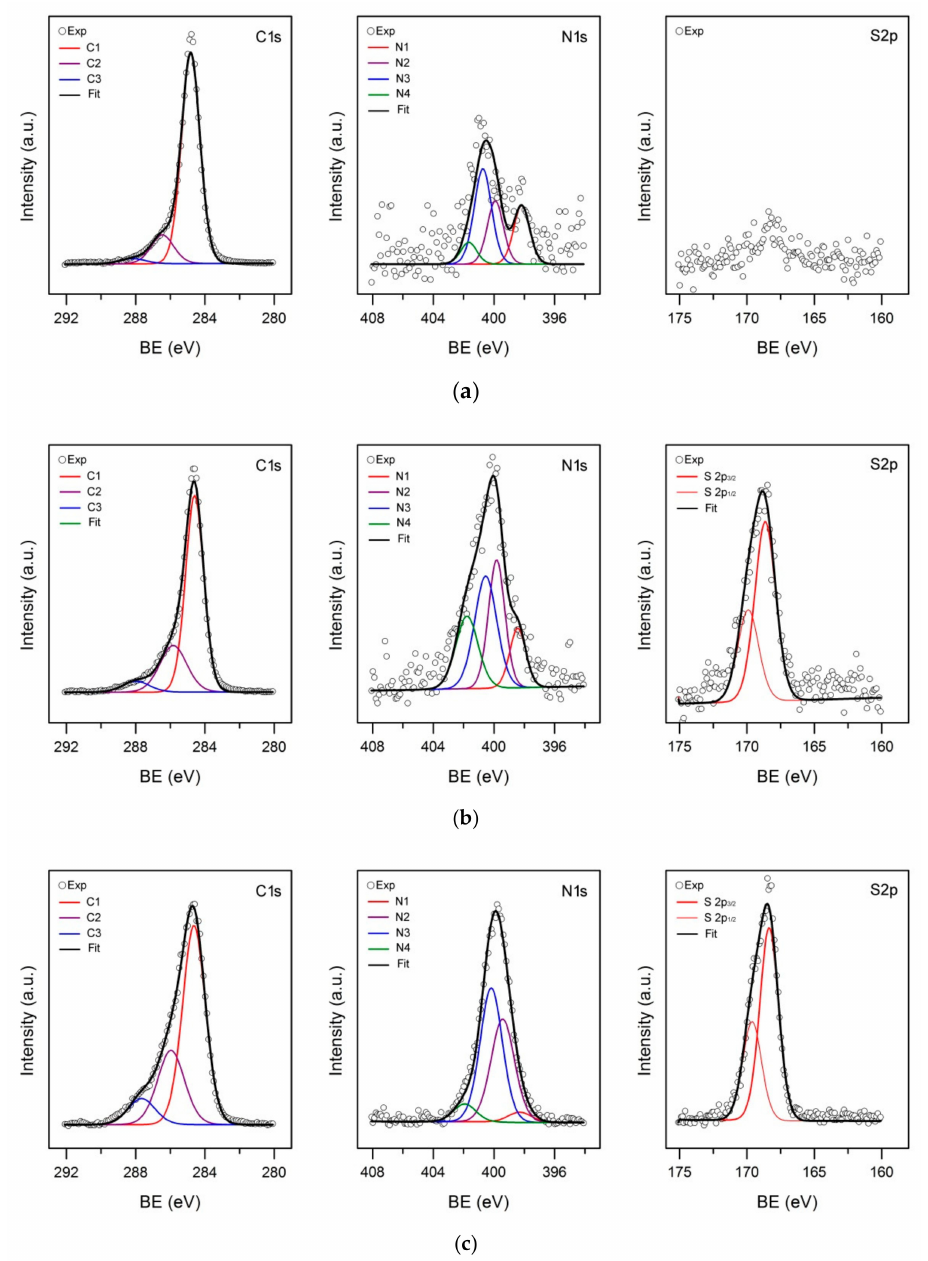
Figure 5. High-resolution C1s, N1s and S2p core-level X-ray photoelectron spectra of ( a ) untreated ACC andhybridPAni-ACCcompositessynthesizedafter( b )40minand( c